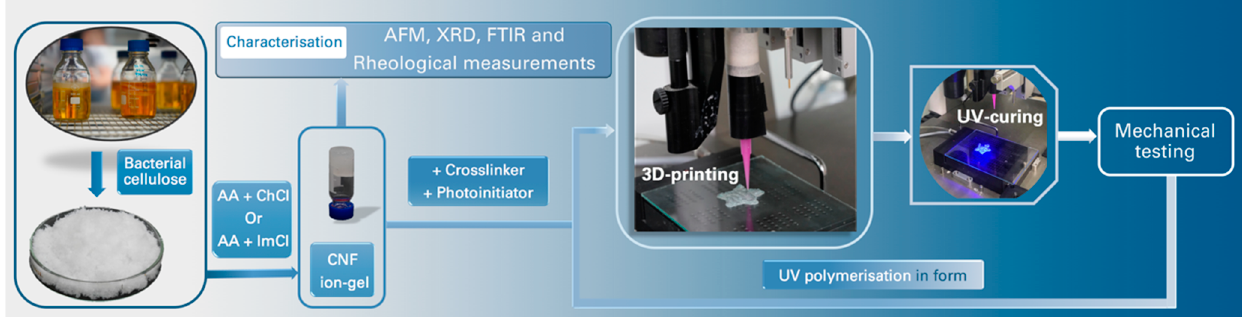
Figure 4. Block scheme demonstrating the preparation of materials and their characterization.